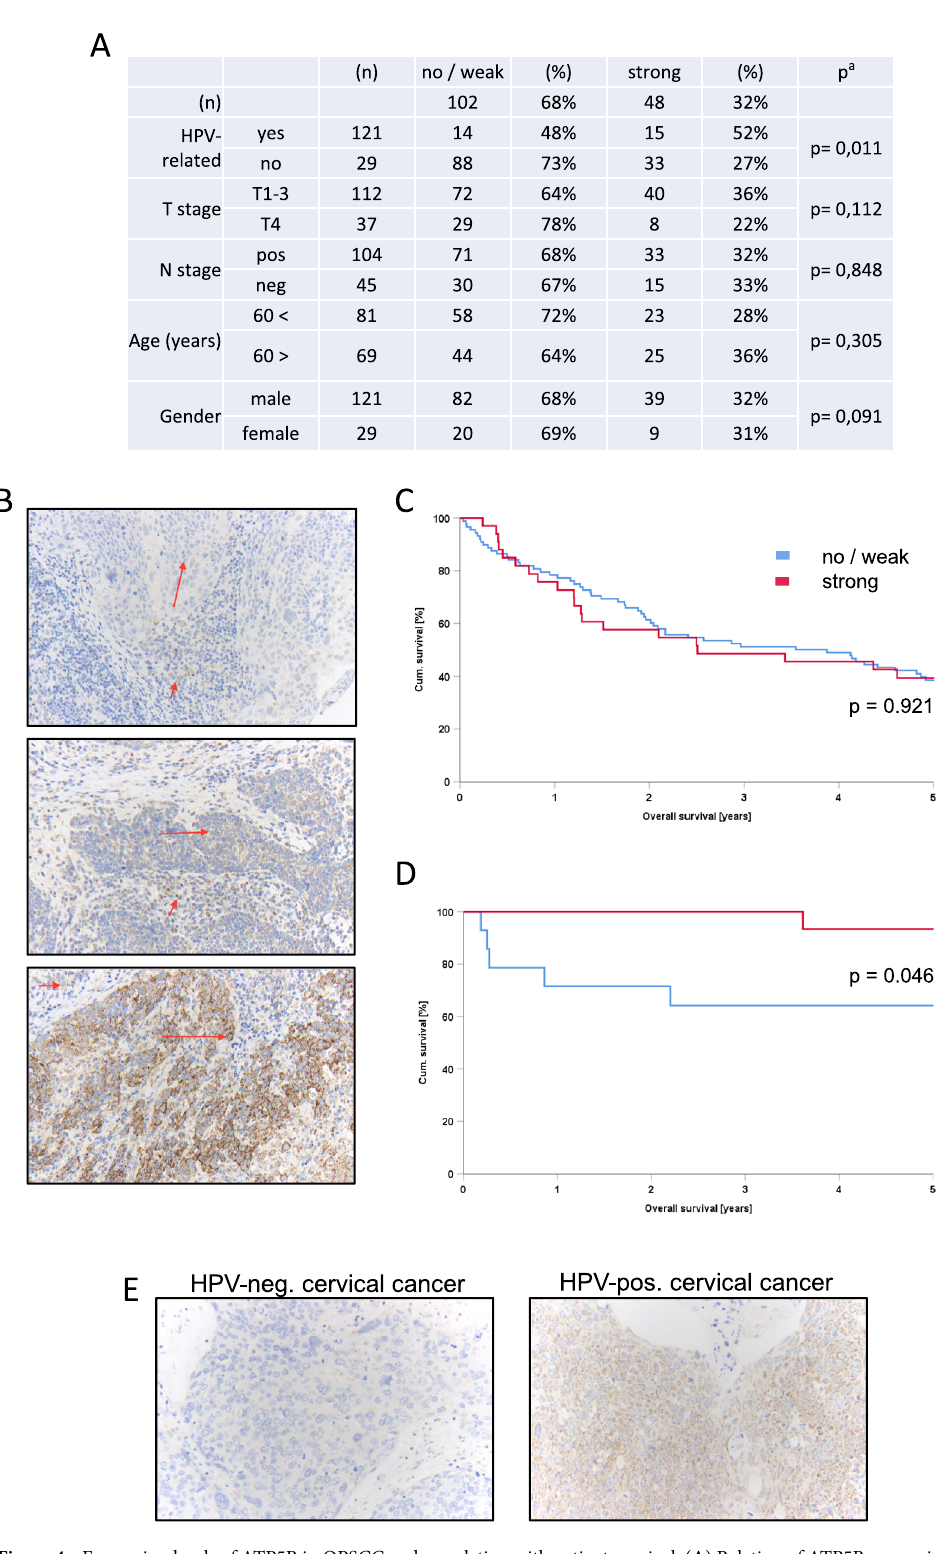
Figure 4. Expression levels of ATP5B in OPSCC and correlation with patient survival. ( A ) Relation of ATP5B expression according to risk factors and tumor/patient characteristics (n = 150). a p values calculated by x 2 test (Pearson, asymptotic, two-sided), significant p-values (p ≤ 0.05) in bold. ( B ) Shown are three immunohistochemical staining intensities. Negative in carcinoma cells (0), weak expression (2 +) and strong expression in carcinoma cells (3 +). The long arrows mark the carcinoma cells, the short arrows the on-slide control in surrounding inflammatory cells (magnification: 200 ×). Overall survival of patients with HPV-negative ( C ) or positive ( D ) OPSCC correlates with ATP5B expression levels (top: HPV-negative; bottom: HPV-positive). ( E ) Representative immunohistochemical staining of ATP5B son HPV negative (n = 6) and high-risk HPV positive (n = 48) cervical cancer